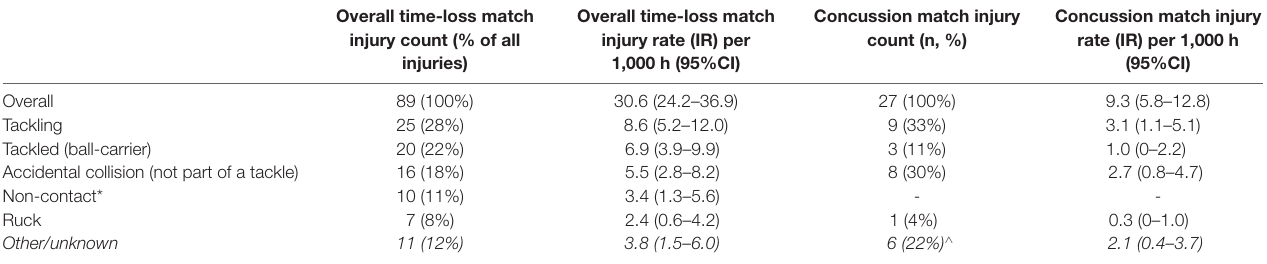
TABLE 3 | Phases of play associated with overall match injuries (total of 89) and match concussion injuries (total of 27); the number, proportion and IR (95%CI).